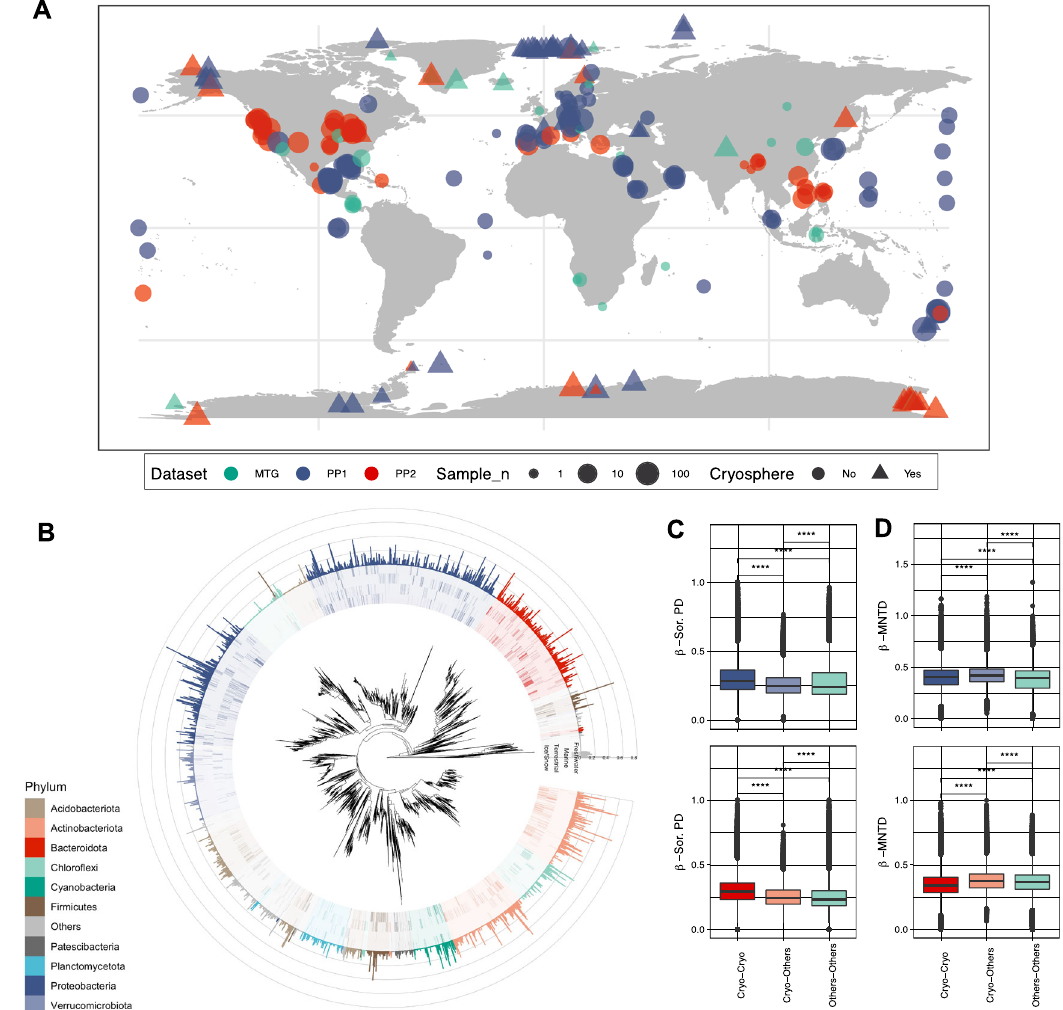
Fig. 1 A unique cryospheric microbiome. A Geographic distribution of the 16 S rRNA gene samples for the two primer pairs (PP) and metagenomes for both cryospheric and non-cryospheric ecosystems, where GPS coordinates were available on NCBI. Symbol size denotes the number of samples per site (see Supplementary Table 7). B Phylogenetic tree based on abundant ASVs (>0.5% relative abundance in at least one sample) in the PP1 dataset. The heatmap (inner rings) shows the presence (at a > 0.5% relative abundance threshold) of ASVs in the four ecosystem types of the cryosphere (ice and snow, terrestrial, coastal ocean and freshwater). The barplot (outer ring) represents the coef fi cient for the SVM classi fi er analysis, highlighting discriminating ASVs. C Sorensen ’ s phylogenetic index of β - diversity ( n 1 = n 2 = 84,461 for PP1, and n 1 = n 2 = 99,000 for PP2) and D β - MNTD calculated across pairs of samples in the cryospheric samples (Cryo-Cryo), pairs of cryospheric and non-cryospheric samples (Cryo-Others) and pairs of non- cryospheric (Others-Others) samples (sample sizes are listed in Supplementary Table 2). The top panel (shades of blue) is for PP1, the bottom one (shades of red) for PP2; two-sided Wilcoxon tests were performed to assess signi fi cance in panels C and D ; the Holm method was used to correct for multiple testing (****: 0 – 0.0001). Boxplots depict the median and the 25th and 75th quartiles, whiskers extend to values within 1.5 times the interquartile range, and the remaining points are outliers. Effect sizes and exact p -values are available in Supplementary Table 2. Source data are provided as a Source Data fi